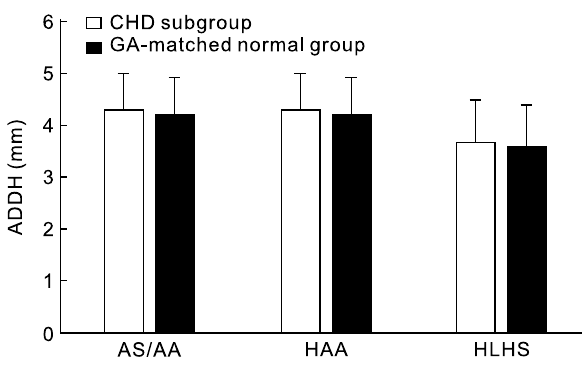
Figure 2 ADDH differences between the left-side obstruction lesions and GA-matched normal subgroups. ADDH, aortic diameter at the diaphragmatic; CHD, congenital heart disease; GA, gestation age; AS/AA, aortic stenosis or aortic atresia; HAA, hypoplasia of aortic arch; HLHS, hypoplasia of left heart